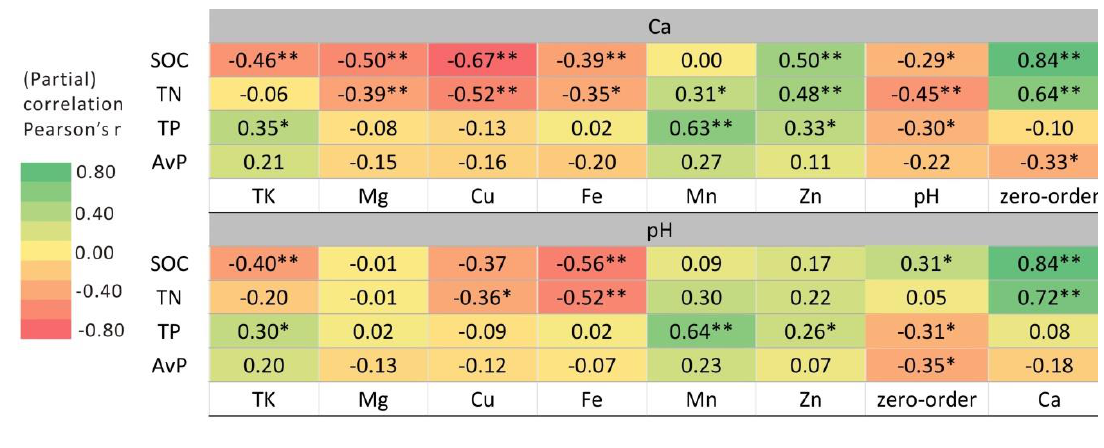
Figure 3. Partial correlation between C, N, and P and geochemical variables. Ca, Mg, Cu, Fe, Mn and Zn represents calcium, magnesium, copper, iron, manganese, and zinc respectively; TK represents total potassium; The color and numbers shown indicate the strength and sign of the correlation. No change in color between controlled and zero-order = no dependency; increase / decrease of color intensity = gain of / loss of correlation. Significance levels are denoted as follows: *, p < 0.05; **, p < 0.01.